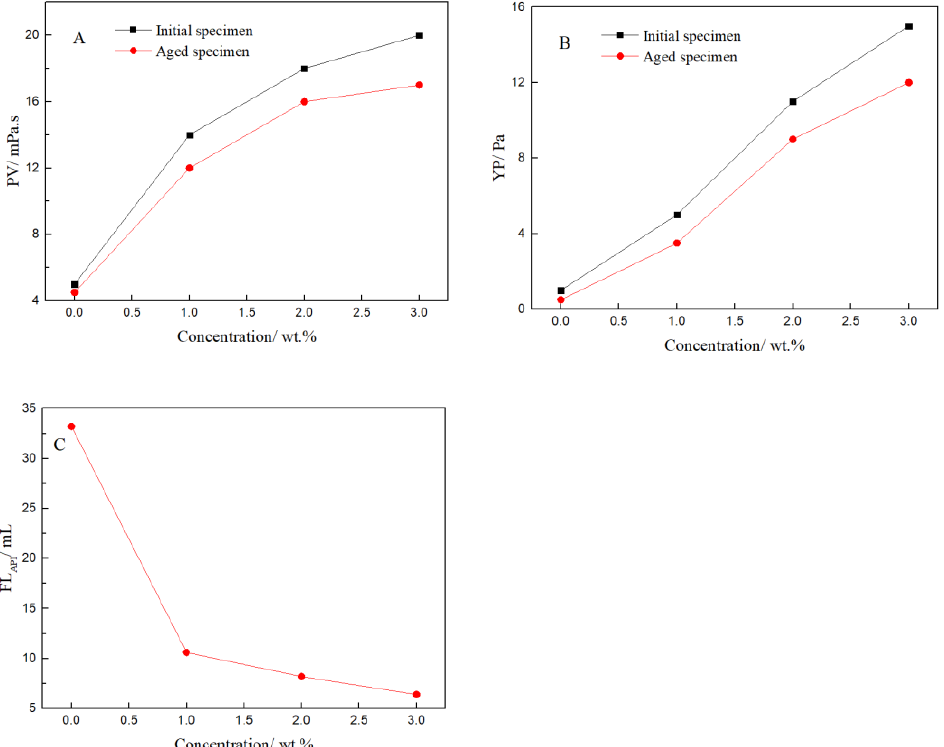
Figure 5. Effect of FLO-H concentration on rheological and filtrate properties of the bentonite-base slurry: ( A ) Plastic viscosity (PV), ( B ) Yield point (YP), ( C ) FL API of the bentonite-base slurry with FLO-H after aging.